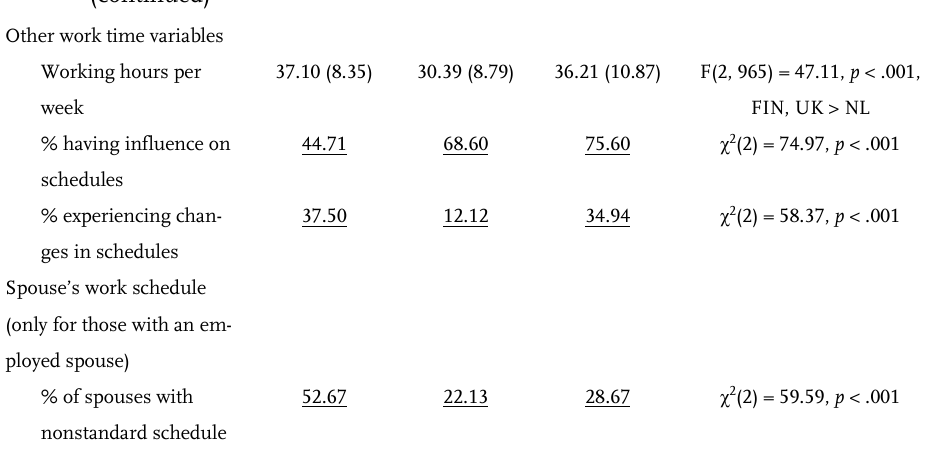
Table 1 : Background information on the Finnish, Dutch and British participants